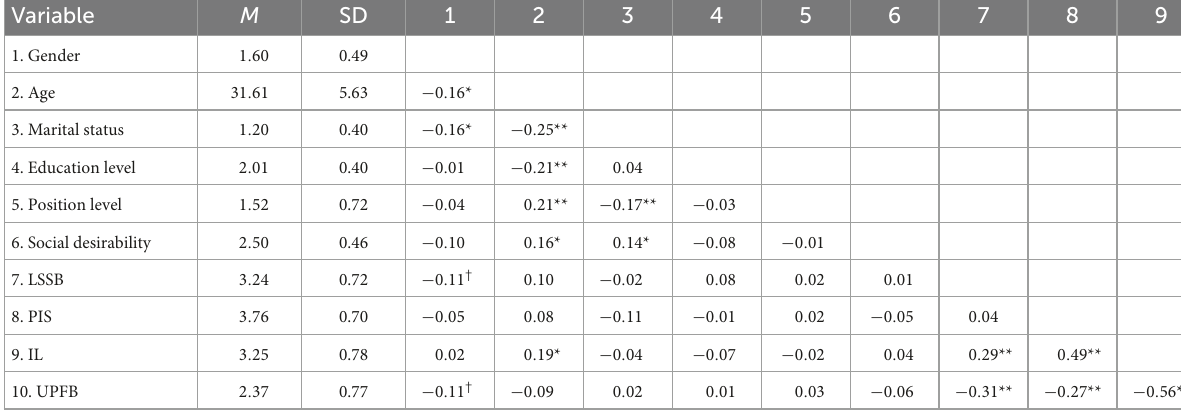
TABLE 2 Means, standard deviations, and correlations.